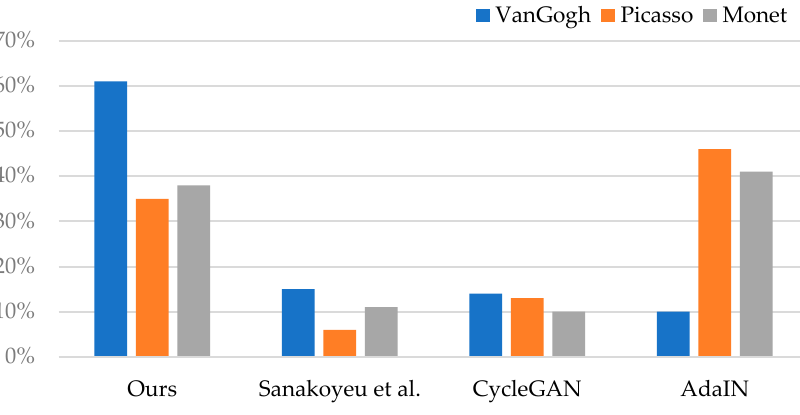
Figure 12. Comparison of user votes between methods.